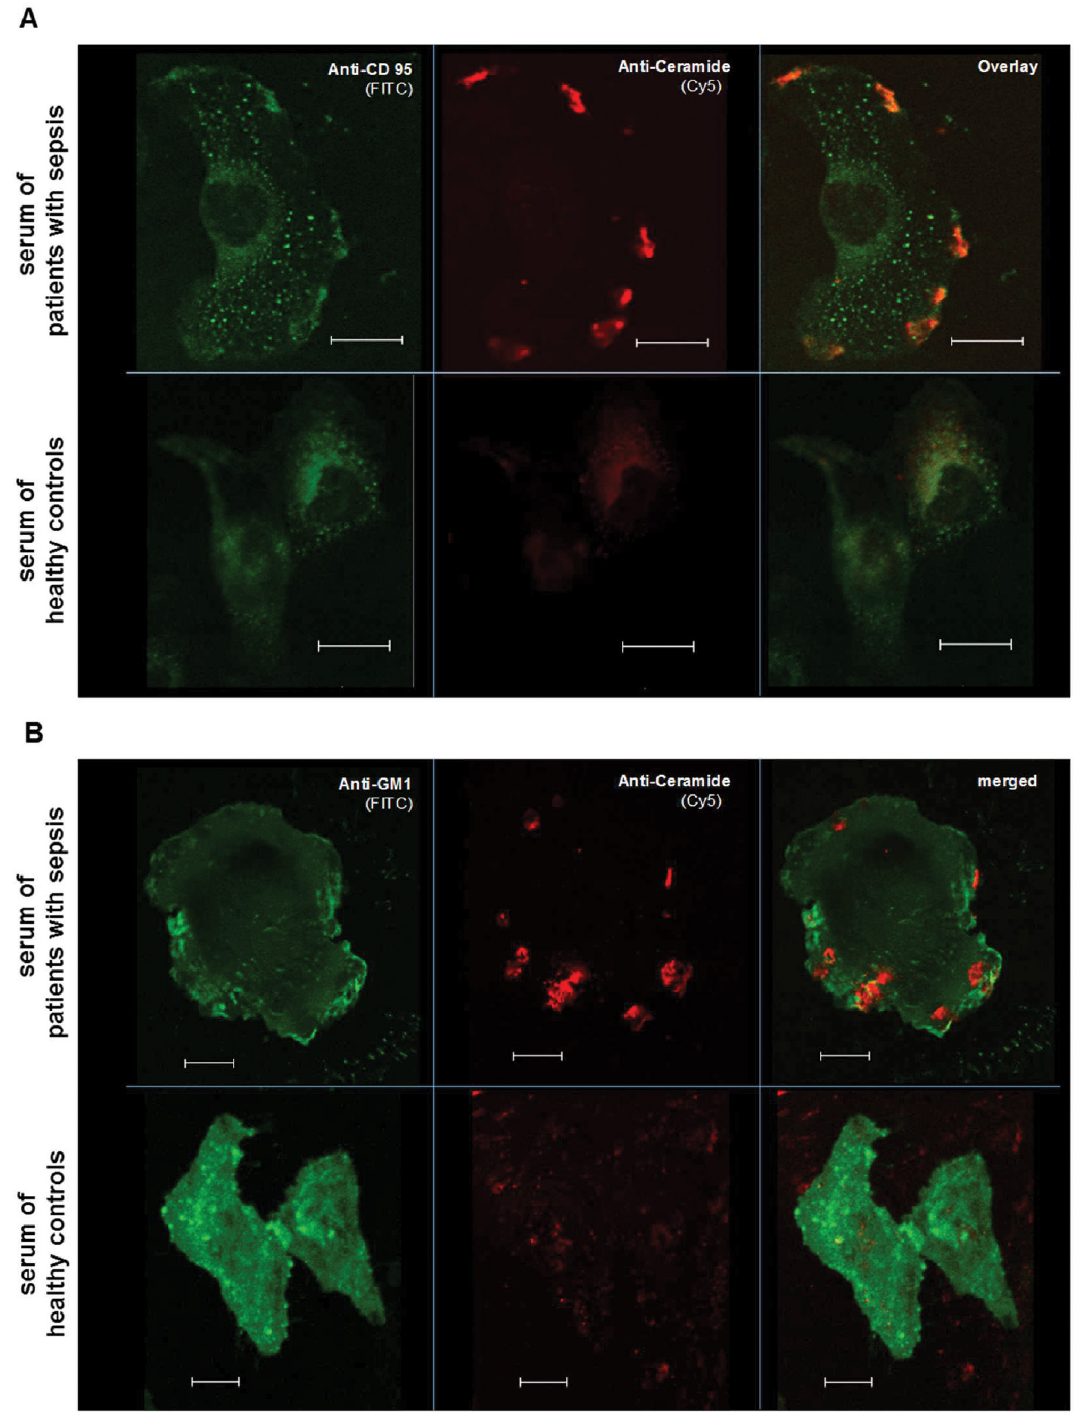
Figure 4. (A) Receptor clustering in ceramide-enriched macrodomains in stimulated endothelial cells. (B) GM1-membrane sorting and ceramide-enriched macrodomain formation in stimulated endothelial cells. Semi-confluent HMECs were stimulated for 20 min with serum (5%) from healthy individuals (lower panel) or from patients with sepsis (upper panel). Subsequent to fixation and blockade of unspecific binding, immunoreactivity was assessed with polyclonal anti-CD95, GM1 antibody and monoclonal anti-ceramide antibody using identi- cal experimental settings in all conditions. Representative images from at least six independent experiments are